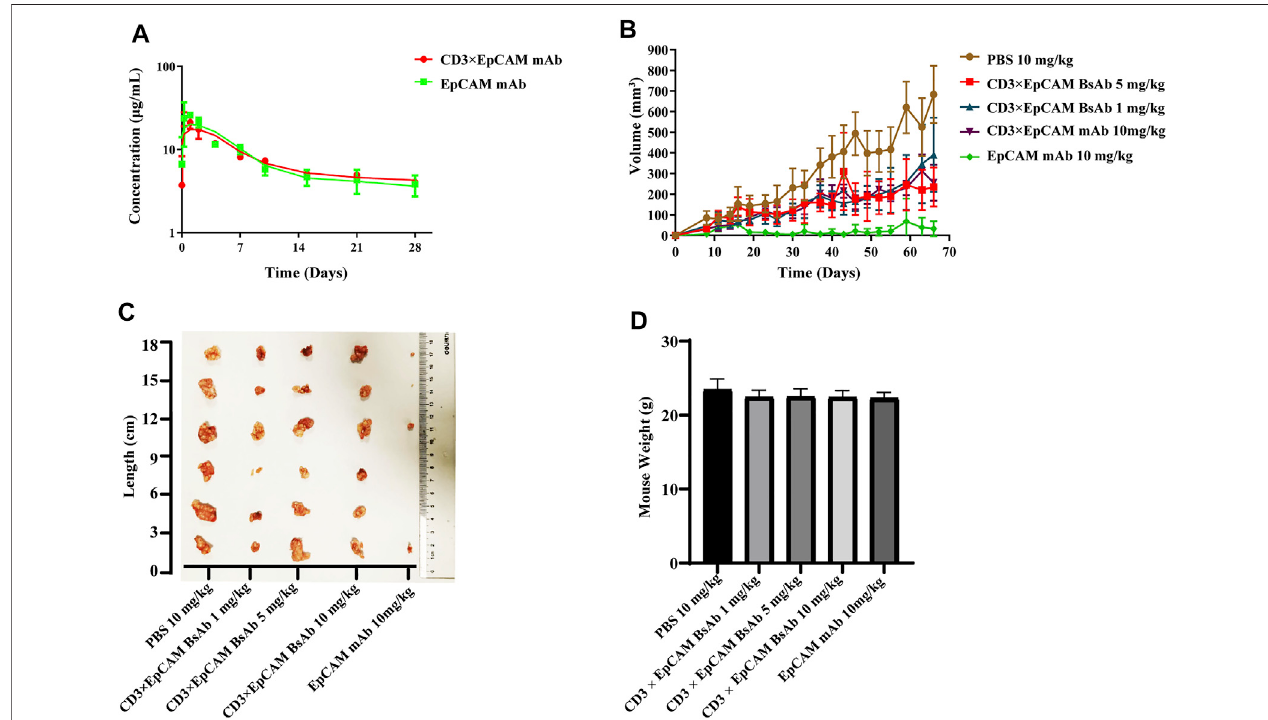
FIGURE6| Invivo bioactivityassayofCD3×EpCAMBsAbinxenograftNOD/SCIDmousemodel. (A) Invivo PKanalysisofCD3×EpCAMBsAbandEpCAMmAbin Balb/c mice (N = 5). (B) Tumor growth inhibition ef fi cacy of CD3×EpCAM BsAb. Mice were implanted subcutaneously with 6×10 6 SW480 cells mixed with 2×10 6 unstimulated human PBMC (E: T = 1:3). Mice (N = 6) were treated through intraperitoneal injection with PBS vehicle control, EpCAM mAb, or CD3×EpCAM BsAb at different dosages per mouse per week. (C) Excised tumor results showed on double-blind order. (D) Weight comparison of different groups. Error bar, SD.